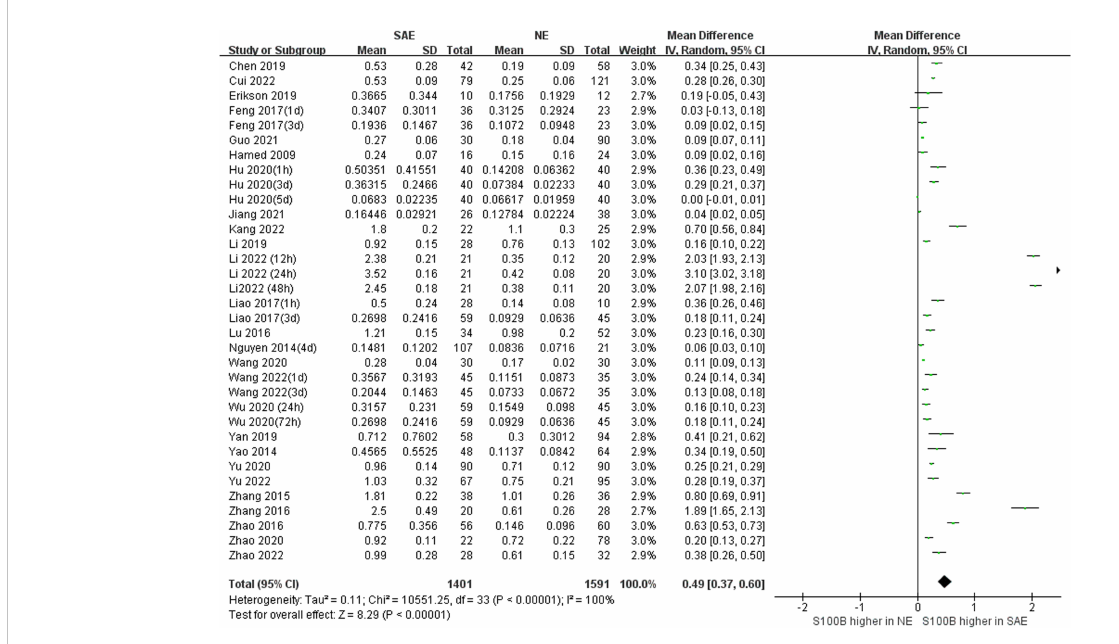
FIGURE 4 Meta-Analysis forest plot: association between serum S100B level and patients with SAE.